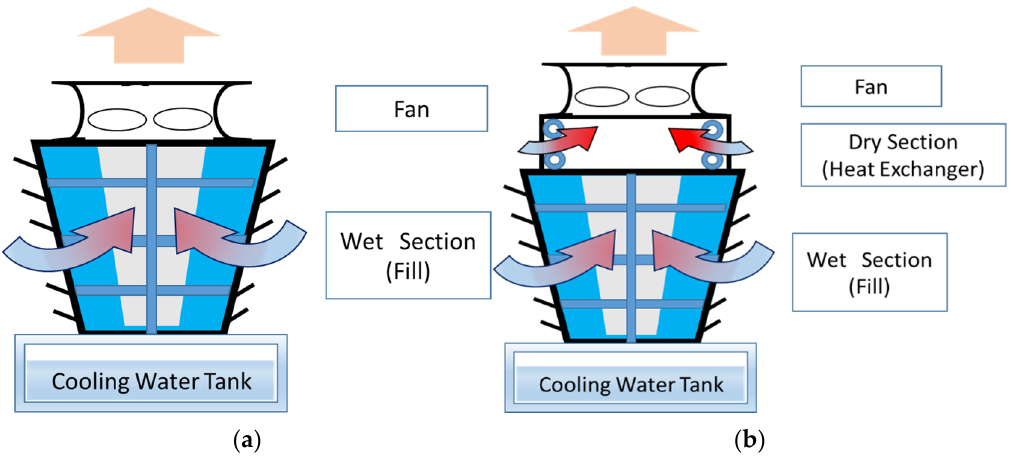
Figure 1. Schematics of cross flow cooling towers with a mechanical draft device (rotating fan): ( a ) wet type; ( b ) dry and wet combined type.